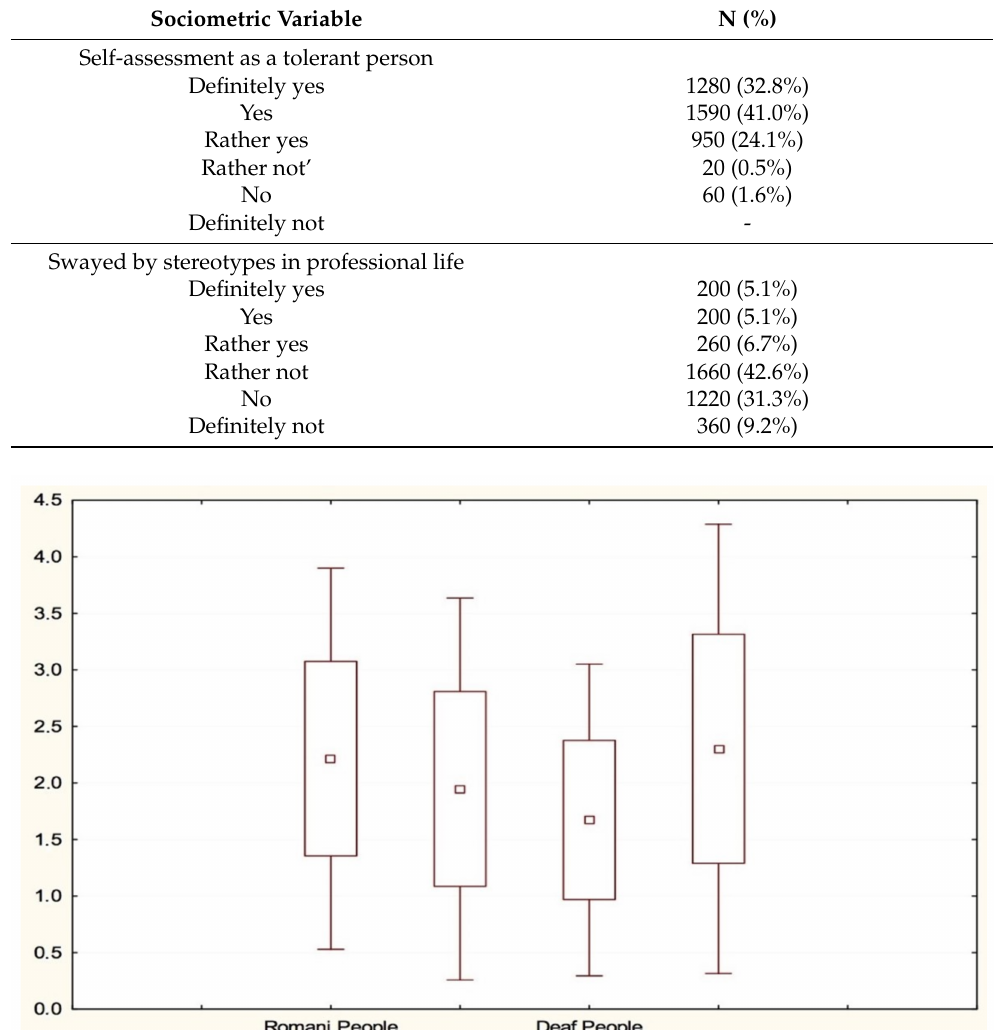
Table 2. Self-assessment of respondents as tolerant and not swayed by stereotypes in their professional life.